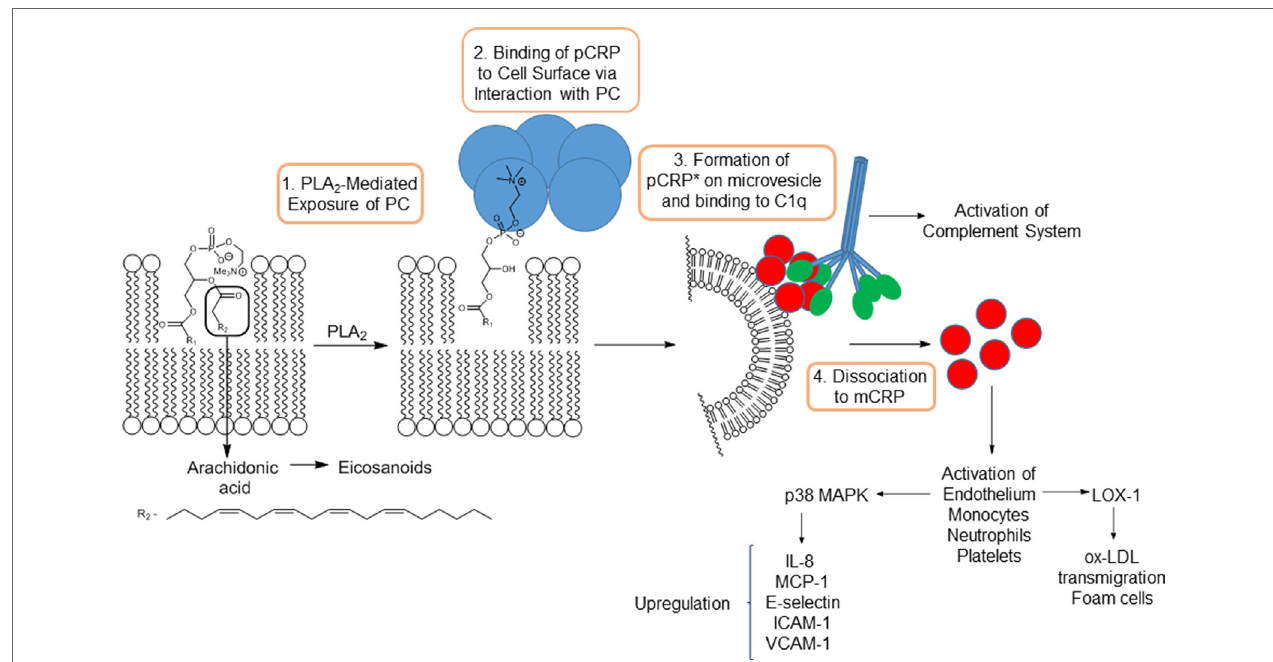
FigURe 1 | Action of PLA 2 on arachidonic acid-containing phospholipids and subsequent mechanism of dissociation of pCRP to